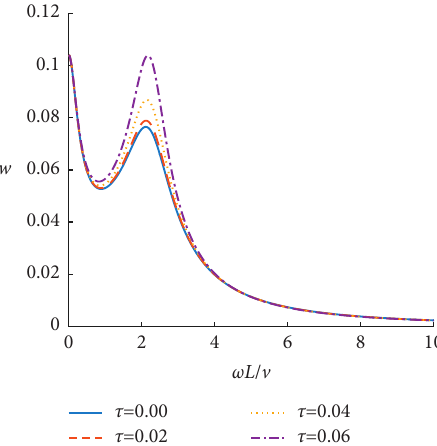
Figure 3: Influence of the nonlocal coefficient on the deflection amplification factor at the midpoint of the beam.